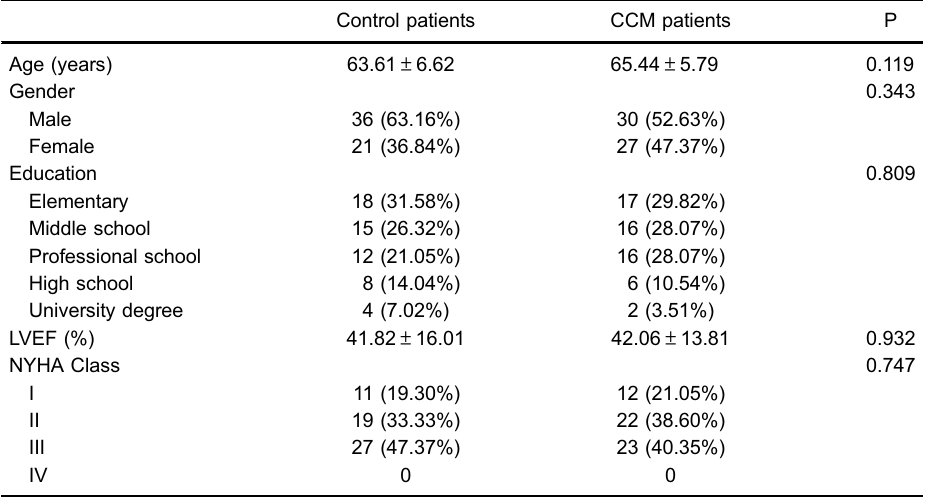
Table 1. Clinical and demographic characteristics of the control group (normal care, n = 57) and the collaborative care model (CCM) group (n=57) of chronic heart failure